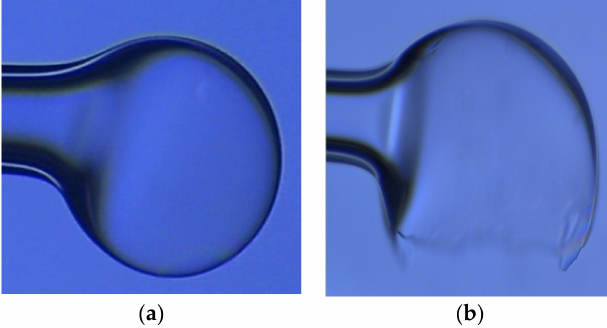
Figure 3. Failed experiment and the specific reason. ( a ) Deformation due to the gravity; ( b ) deformation due to non-uniform wall